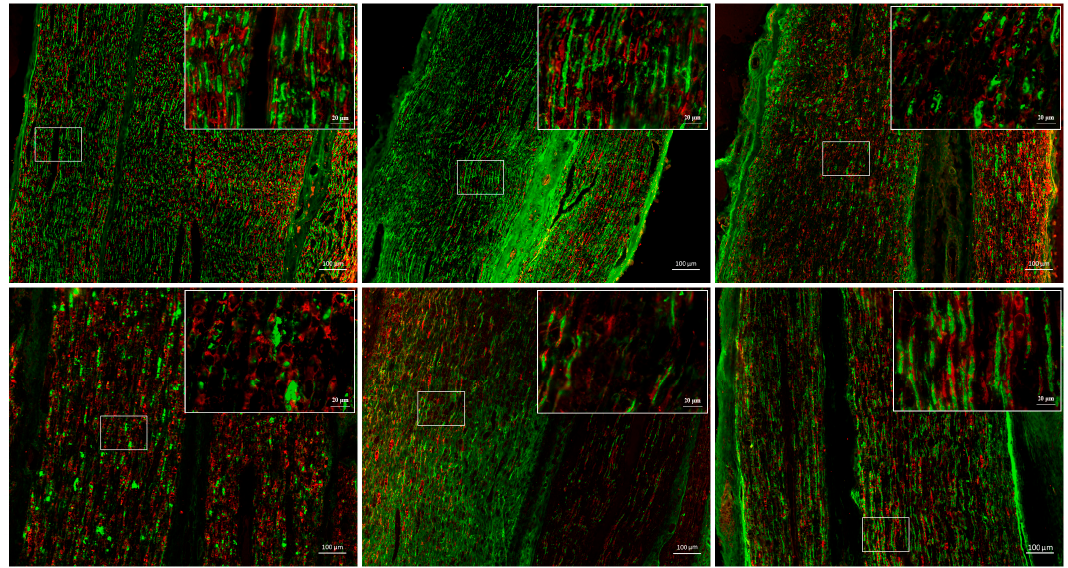
Figure 1. Immunohistochemistry images of distal sciatic nerve at 0, 1, 4, 7, 14, and 21 days post nerve crush. Distal sciatic nerves were stained with anti-NF200 ( green ) and anti-S100 ( red ). Scale bar = 100 µ m. Images in the box to the upper right corner represented the higher magnifications of the boxed areas. Scale bar = 20 μ m.